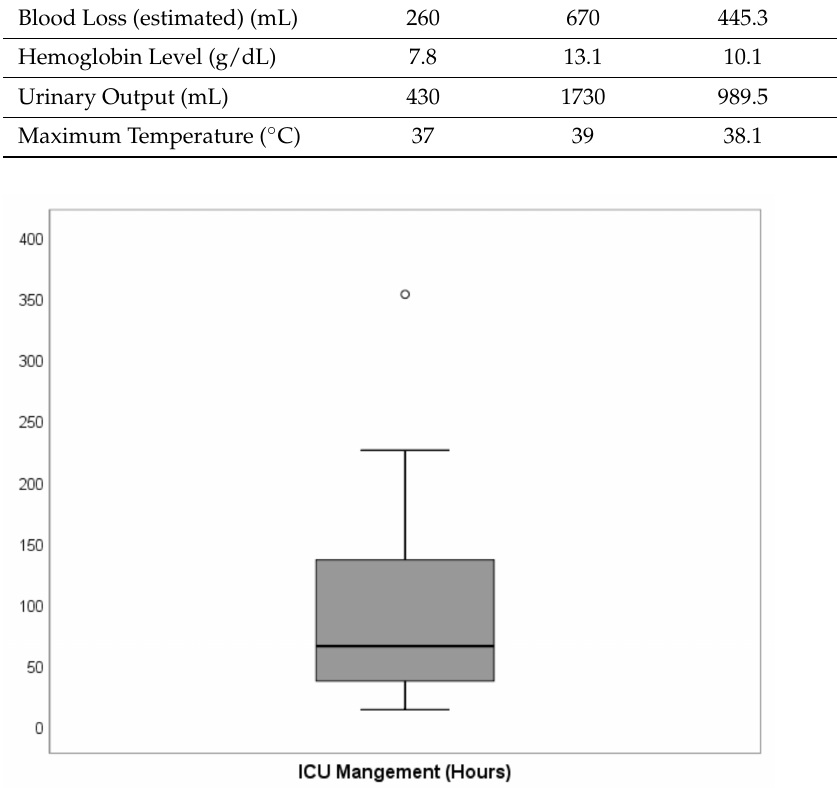
Figure 2. Graphical distribution of the primary outcome, ICU-LOS for all cases ( n = 122). The black bold line indicates the median, while the boxes show the interquartile range (IQR) between 25th and 75th percentile and whiskers indicate the minimum and maximum values within 1.5 × IQR. One extreme value was observed. The detailed values of ICU-LOS are given in Table 2.